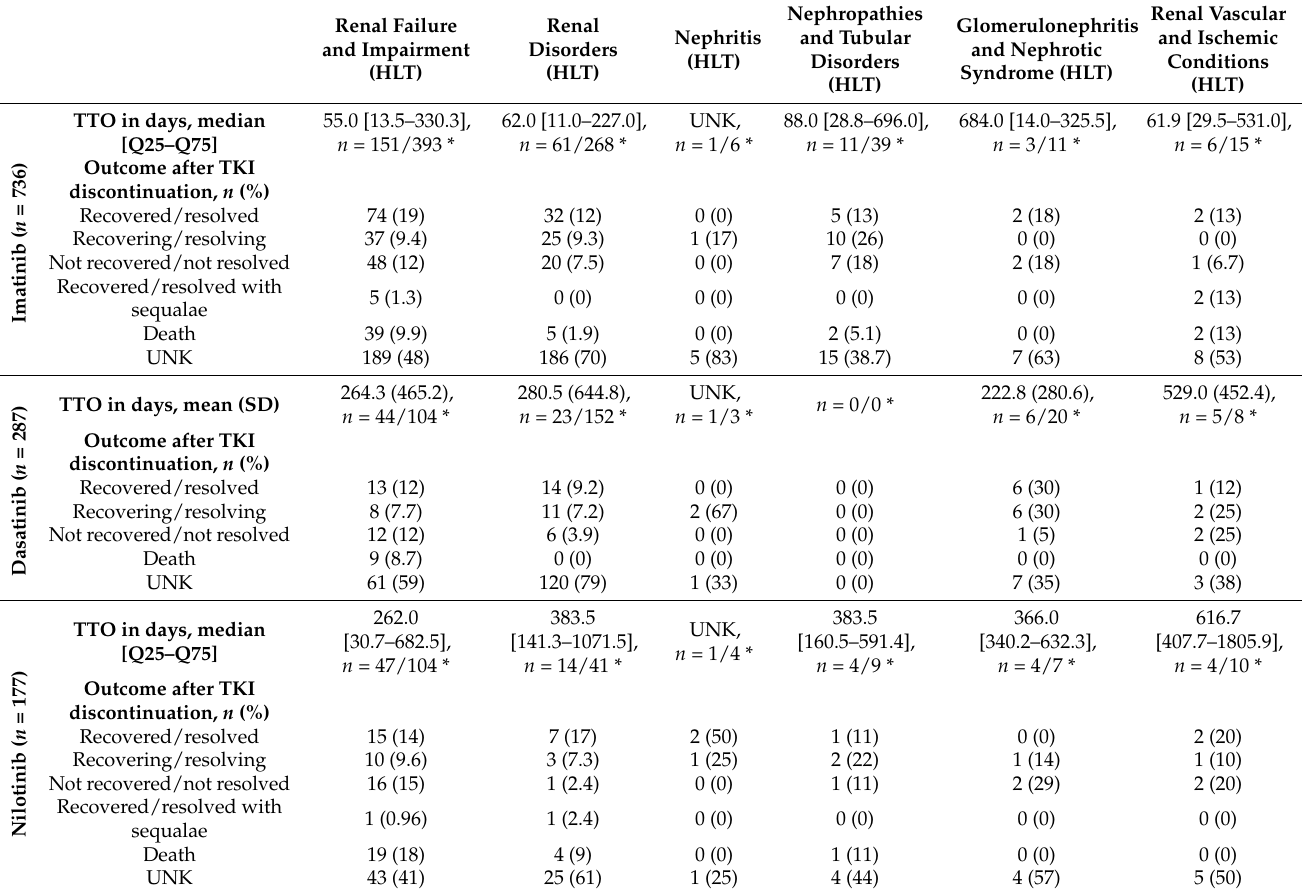
Table 2. Time to onset and outcome for renal ADR (HLT) and the five studied BCR-ABL